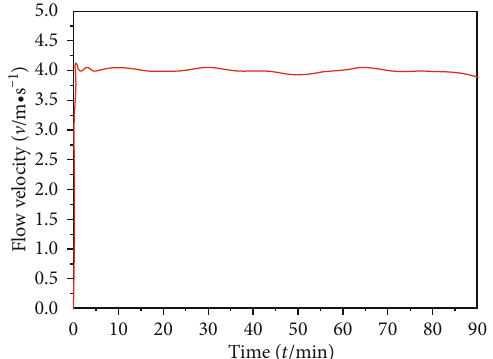
Figure 6: Variation of fl ow velocity in 90